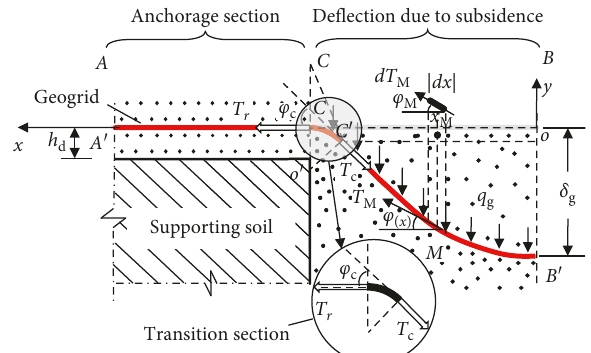
x x and y are the deformed ( ) ( ) ′